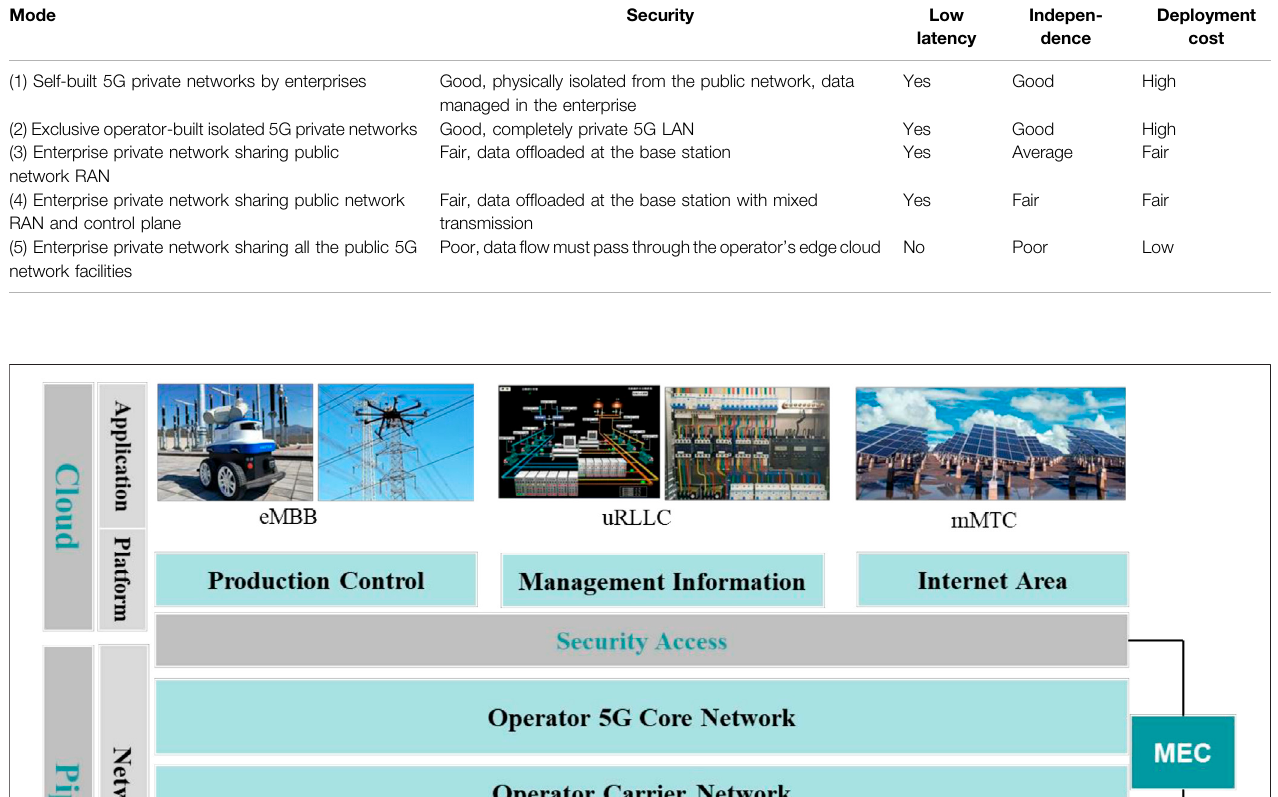
TABLE 1 | Analysis of 5G enterprise networking mode.